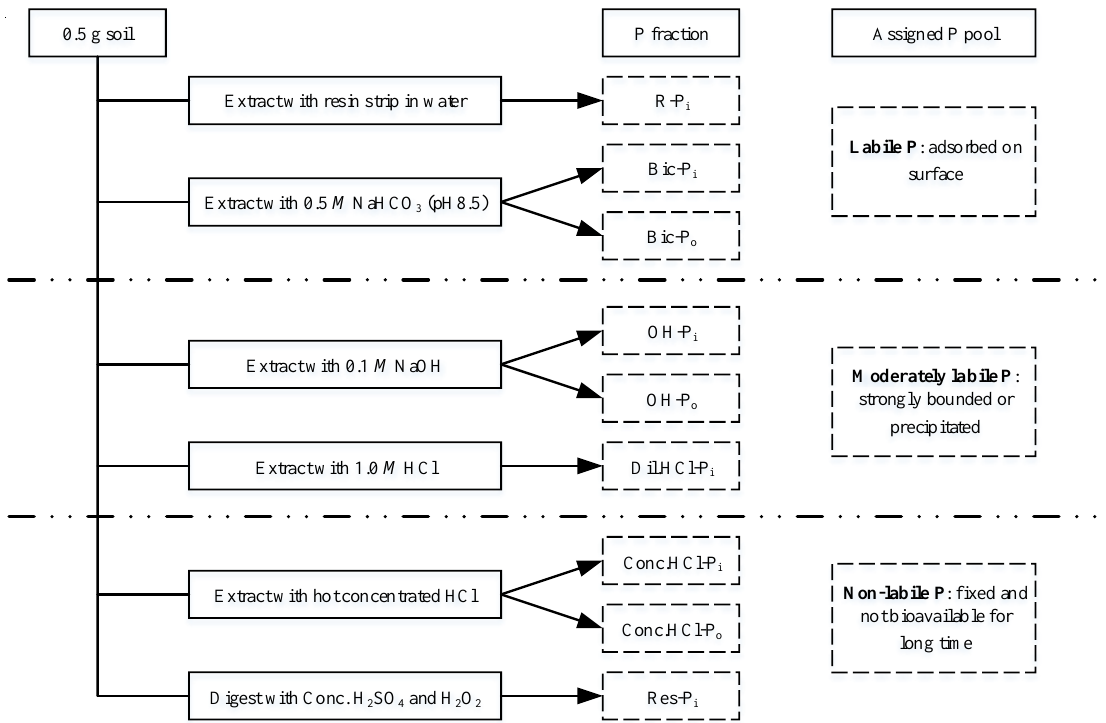
Figure 1. Flow chart of sequential P fractions.